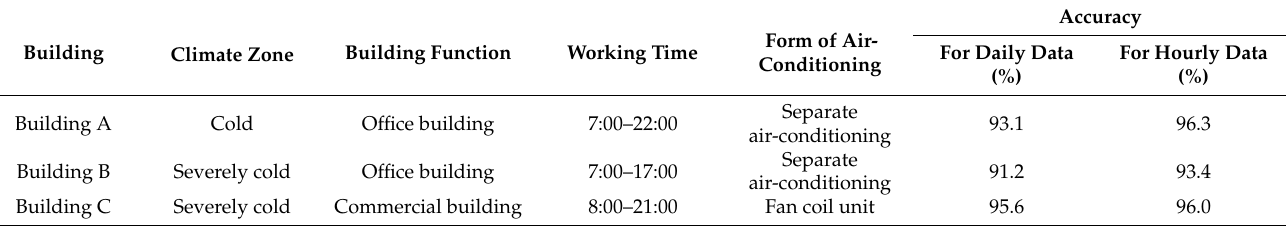
Table 6. Accuracy of identifying operating conditions of